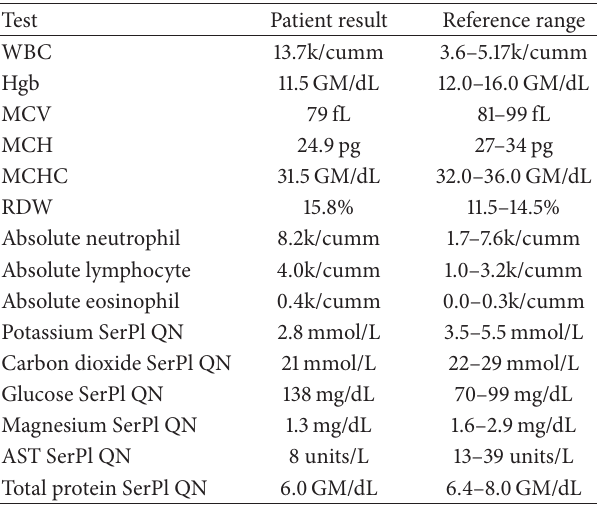
Table 1: Clinical laboratory test results from blood specimens obtained at the time of patient presentation to the